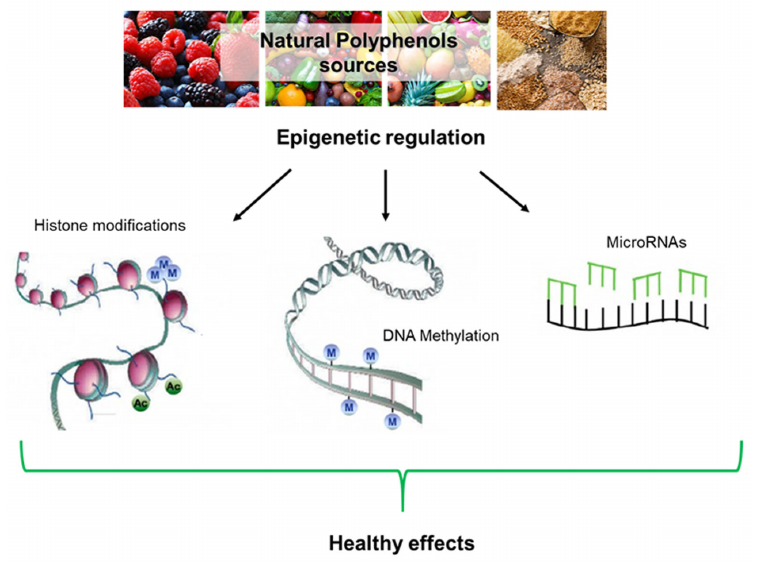
Figure 5. A summary of the epigenetic modifications mediated by plant polyphenols.